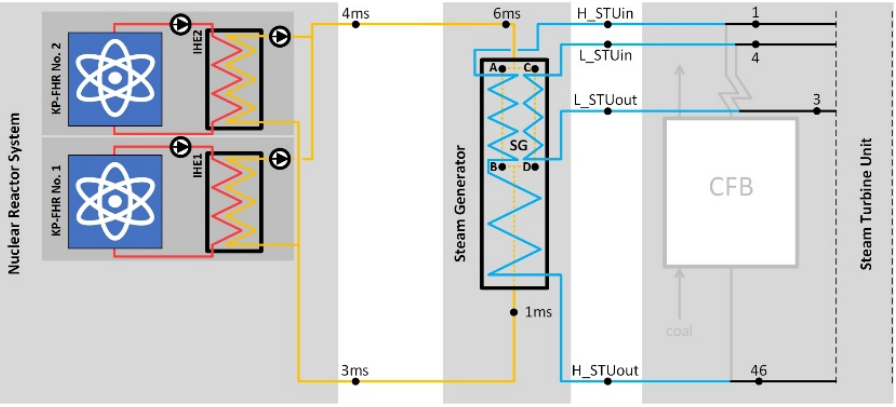
Figure 5. Integration diagram of 2 nuclear reactors with the steam turbine unit (Case REF_2NR).